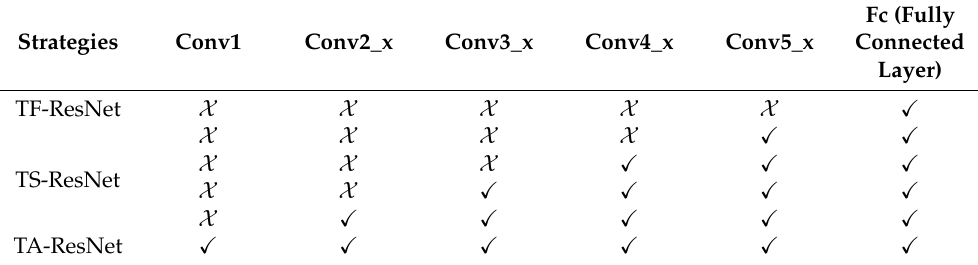
Table 2. Three strategies for fine-tuning the parameters of the ResNet-34 pre-trained model.